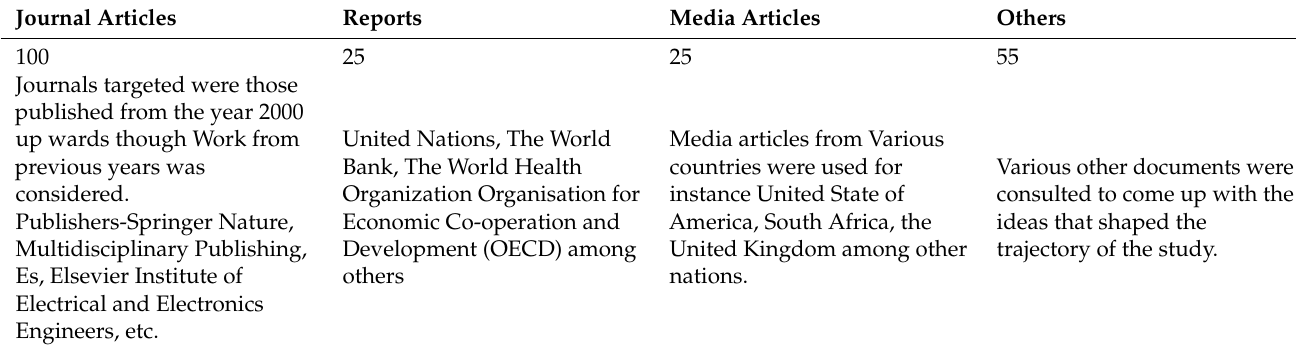
Table 5. Sources that helped in shaping the trajectory of the